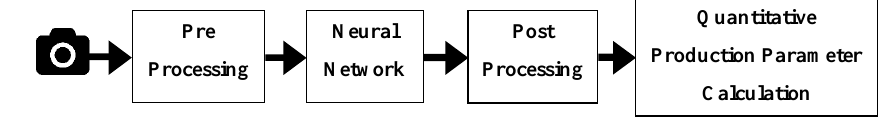
Figure 1. Productivity Index (PI) calculation